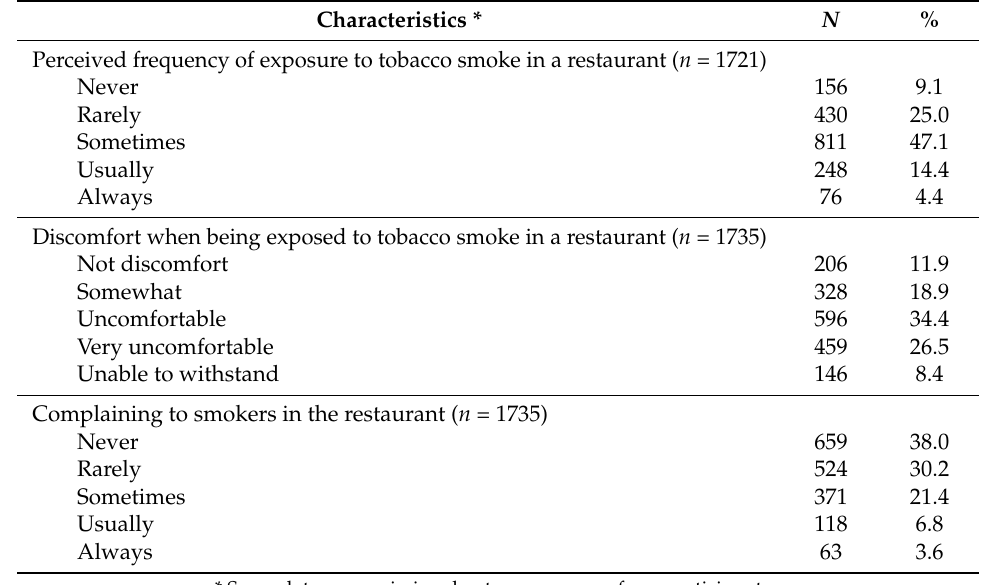
Table 3. Experiences of respondents regarding secondhand smoking in restaurants.